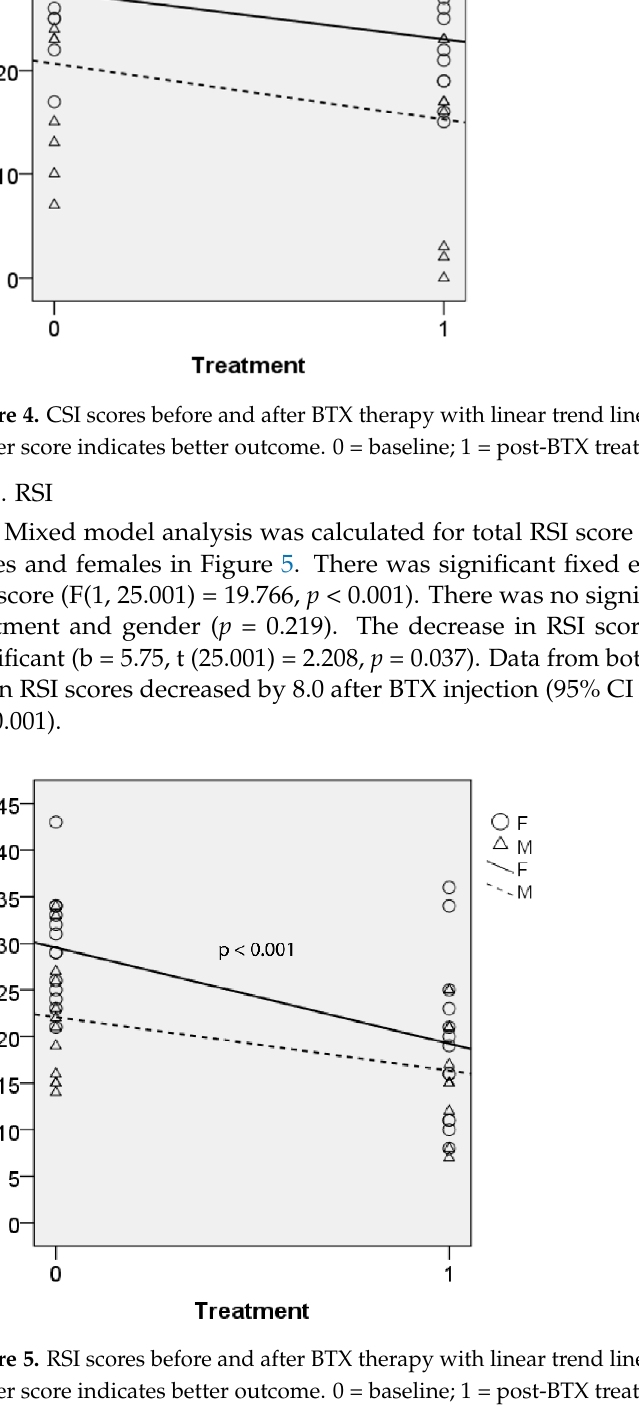
Table 8. Results of paired t test and effect size for RSI items ( n = 25). All items were quoted verbatim from the original RSI scale by Belafsky et al. [63]. Cohen's d: small = 0.2; medium = 0.5; large = 0.8 [75] . MD, mean difference; (*), significant at p < 0.05. RSI Items (from Reference [63])